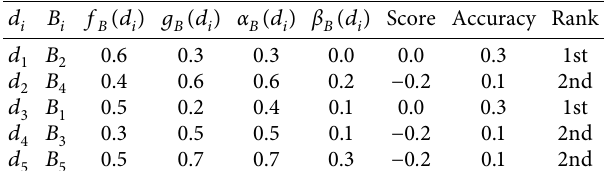
Table 13: LDFNs B i s along with scores, accuracies and rankings on ( B , ⊟ )